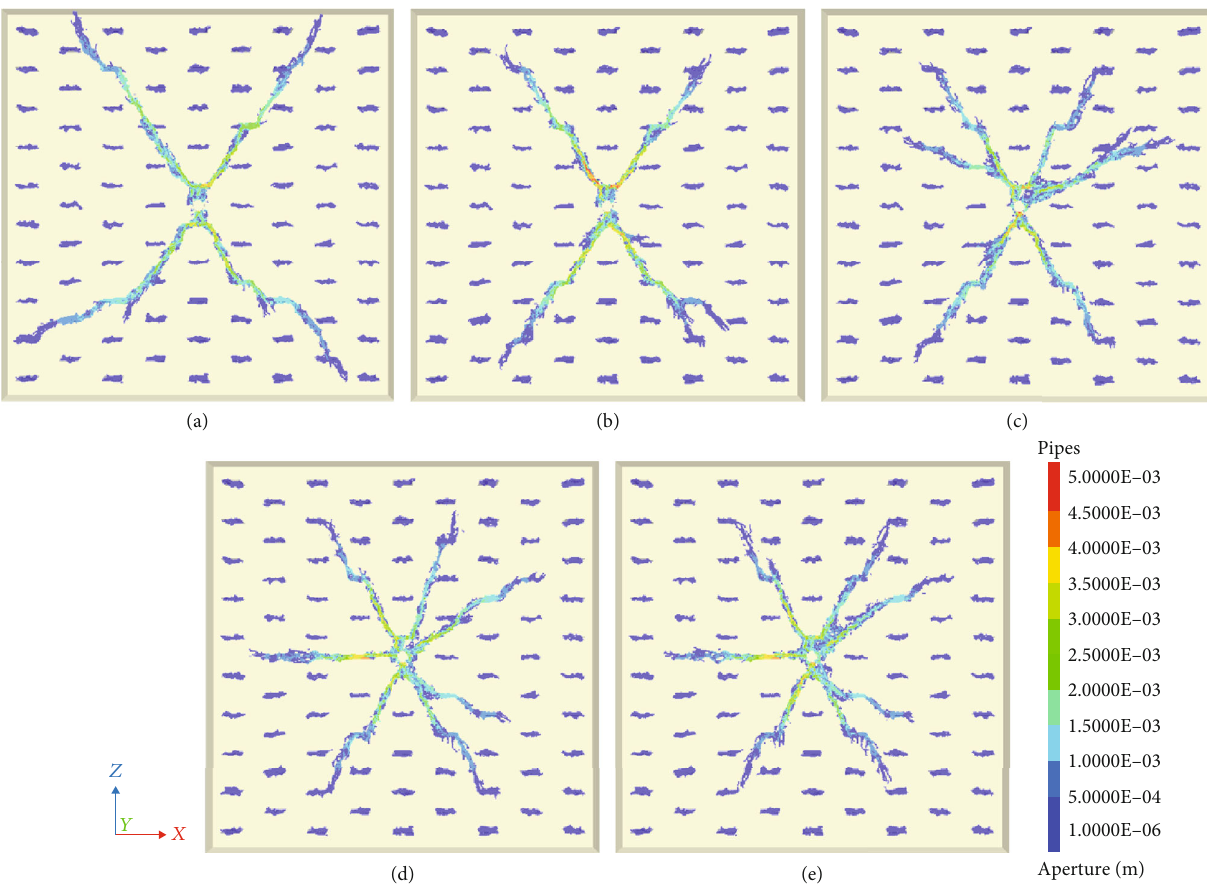
Figure 14: HF propagation in the NFN with di ff erent fl uid viscosities: (a) 1mPa · s, (b) 2mPa · s, (c) 3mPa · s, (d) 4 mPa · s, and (e) 5 mPa · s.